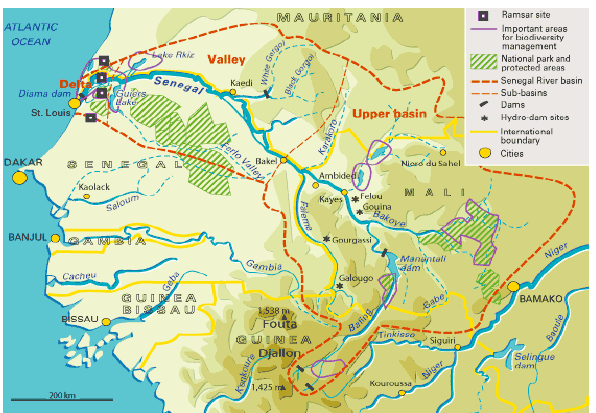
Figure 2: the Ecological Features of the Senegal River Basin